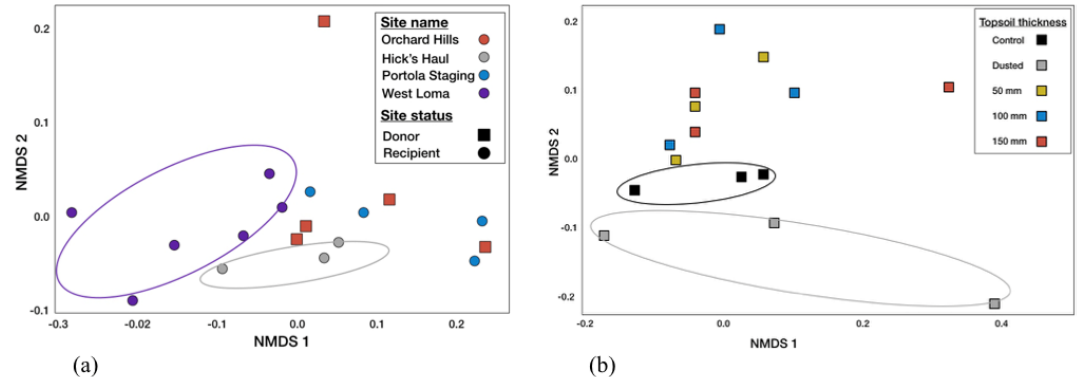
Figure 8. Mycorrhizal community structure across the donor sites (squares) and three recipient sites (circles) in 2015 ( a ) and at one recipient site (Portola) in 2017 ( b ). In 2015, arbuscular mycorrhizal fungi (AMF) community composition at the donor site (panel ( a ), red squares) was more similar to the community composition at Portola Staging area (panel ( a ), blue circles) than the resident AMF communities at both Hick’s Haul (panel ( a ), gray circles) and West Loma (panel ( a ), purple circles). In 2017, we detected a shift in AMF communities at Portola, in the plots with at least 5 cm of salvaged soil, as compared to both control (panel ( b ), black squares) and dusted (panel ( b ), gray squares).